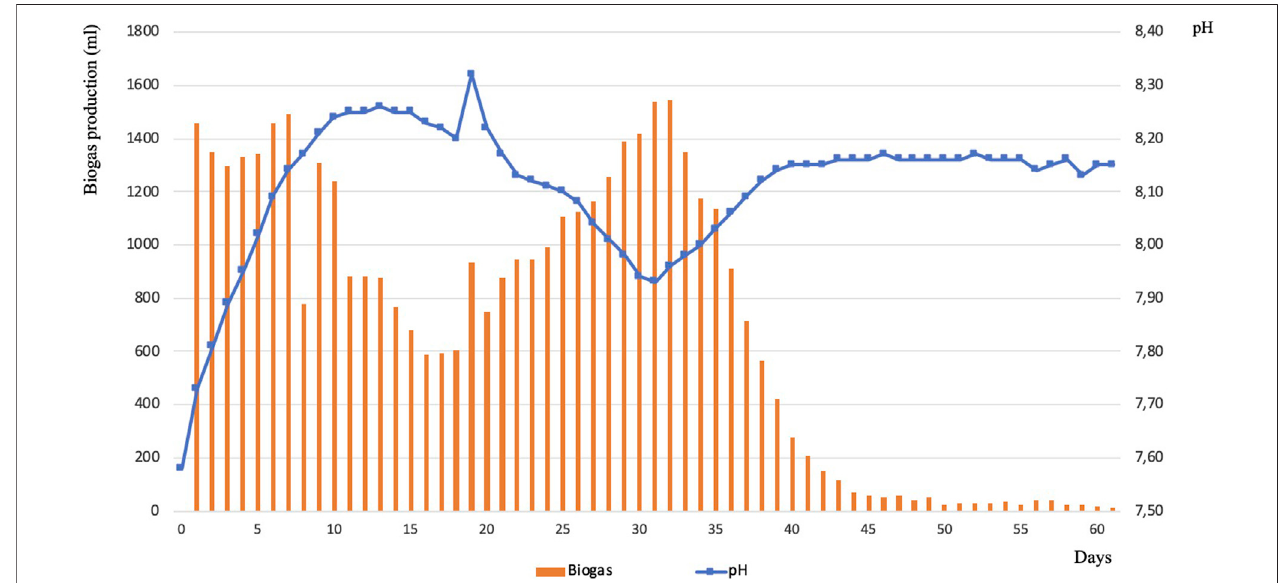
FIGURE 6 | Relation between daily biogas production and